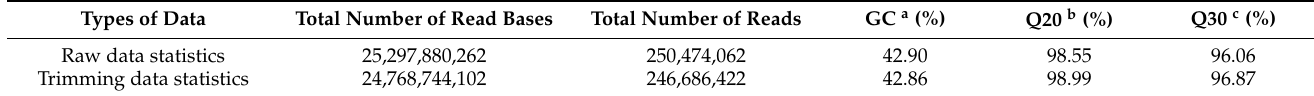
Table 1. The T . koraiensis raw sequenced data and trimmed sequenced data.